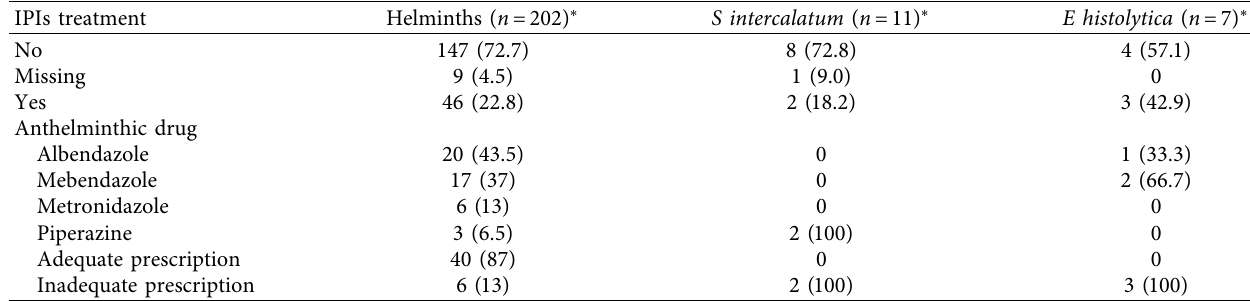
Table 4: ANC anthelminthics prescription registered in the ANC pregnancy cards. IPIs